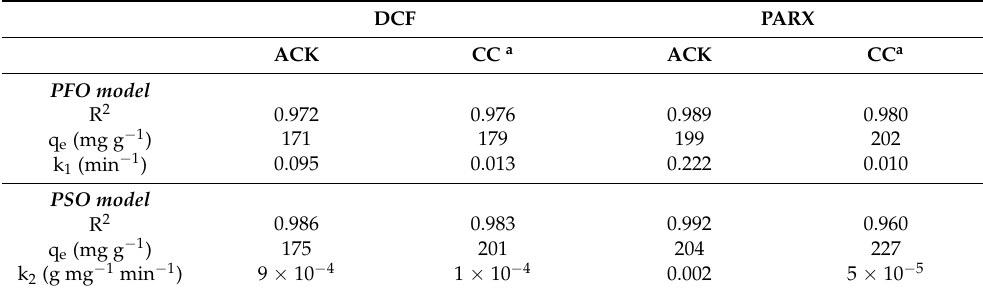
Table 6. Kinetic parameters obtained from the adjustment of the PFO and PSO models to the experimental kinetic data.